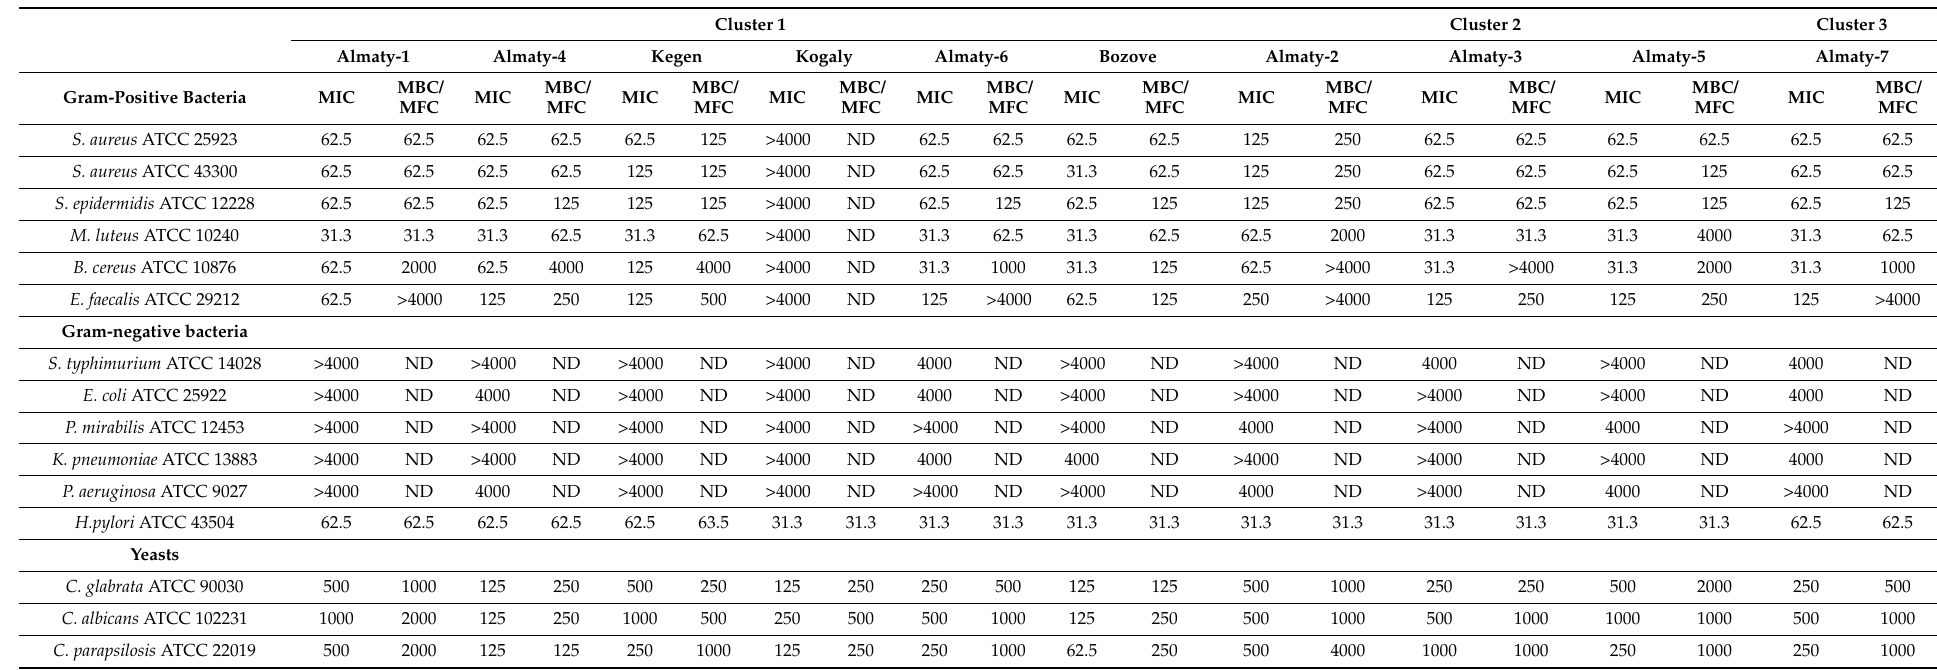
Table legend: * values of MIC, MBC and MFC were expressed as µ